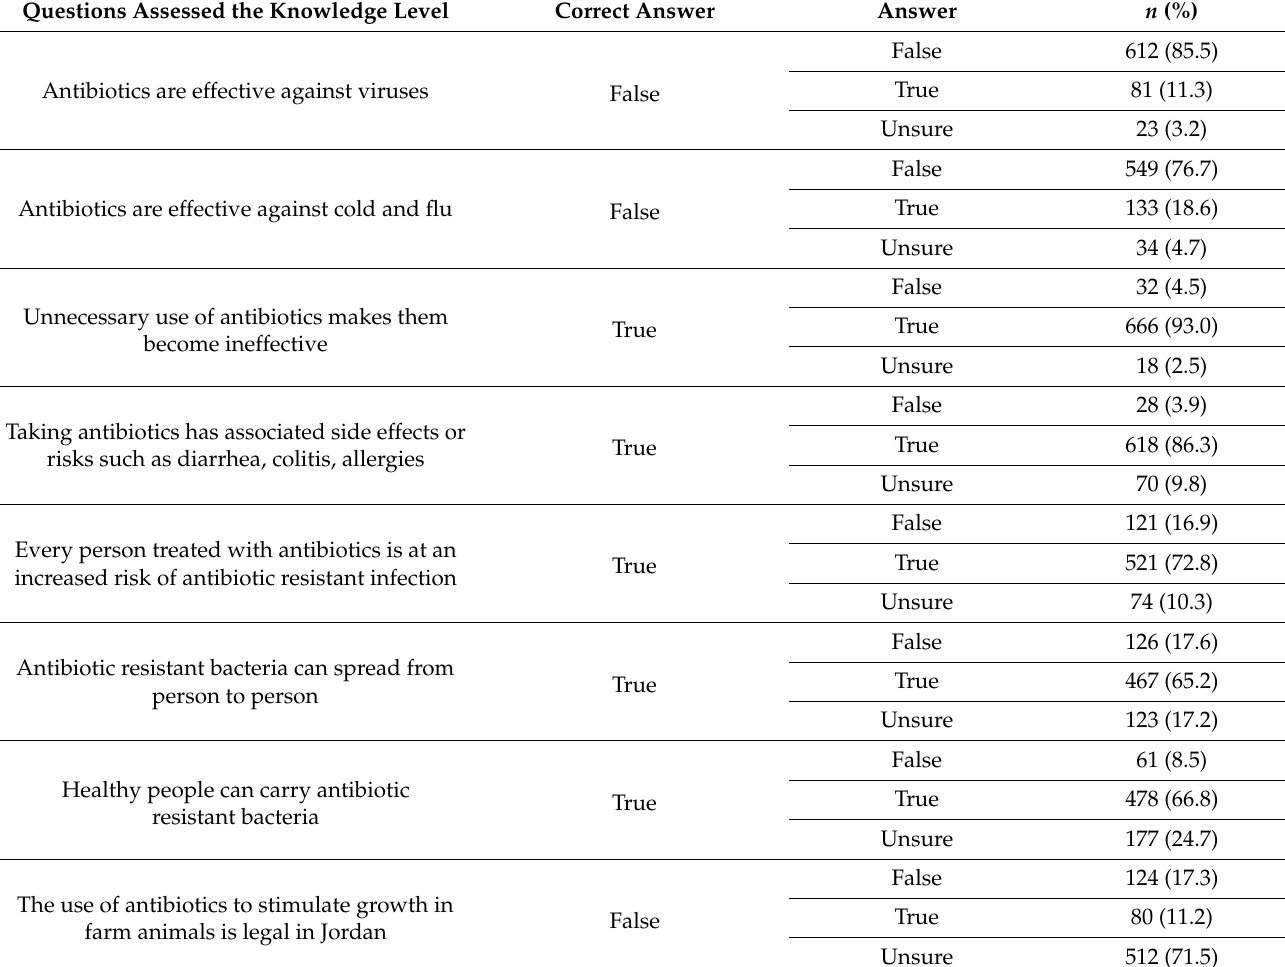
Table 3. Actual knowledge of respondent students related to antibiotic use and